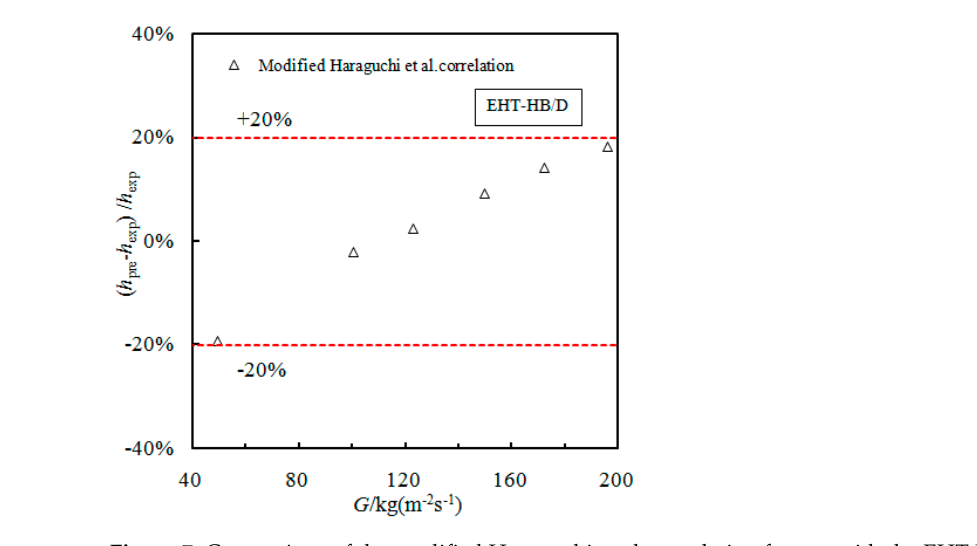
Figure 9. Comparison of condensation thermal resistance ratio of different tube materials ( a ) cop- per ( b ) SS.